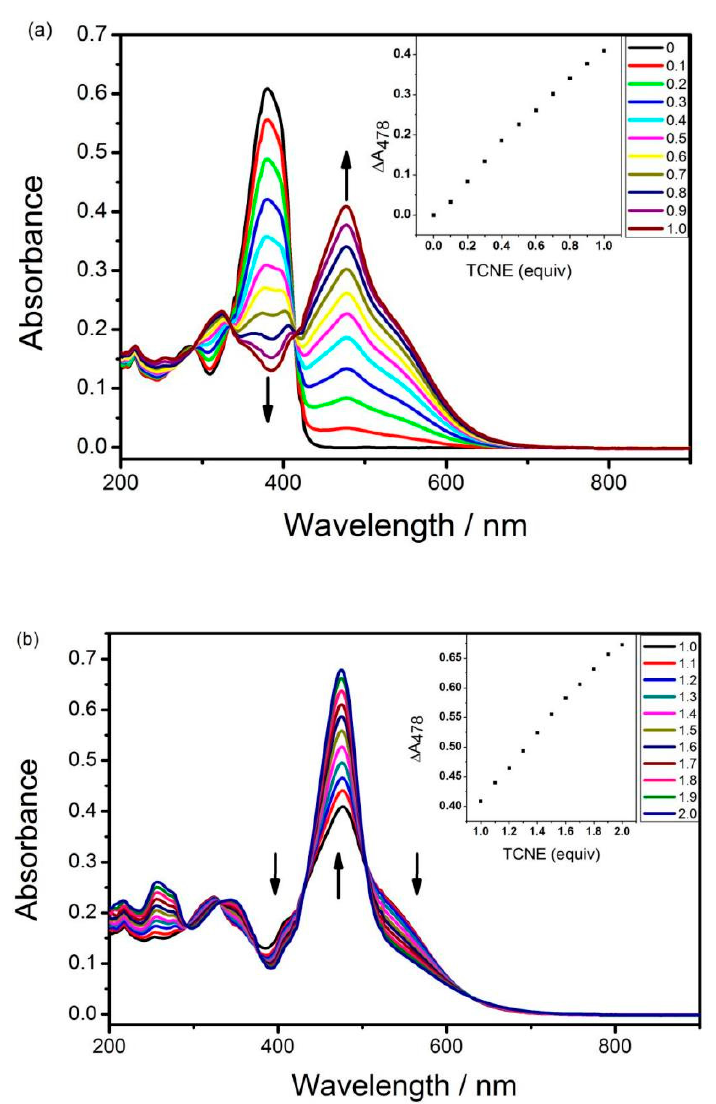
Figure 1. B reaction with quantitative TCNE in CH 2 Cl 2 , rt, to prepare B-11. ( a ) Equivalence ratio 0 to 1.0; ( b ) equivalence ratio 1.0 to 2.0; insertion depicts the change in absorbance by the addition of TCNE at 478